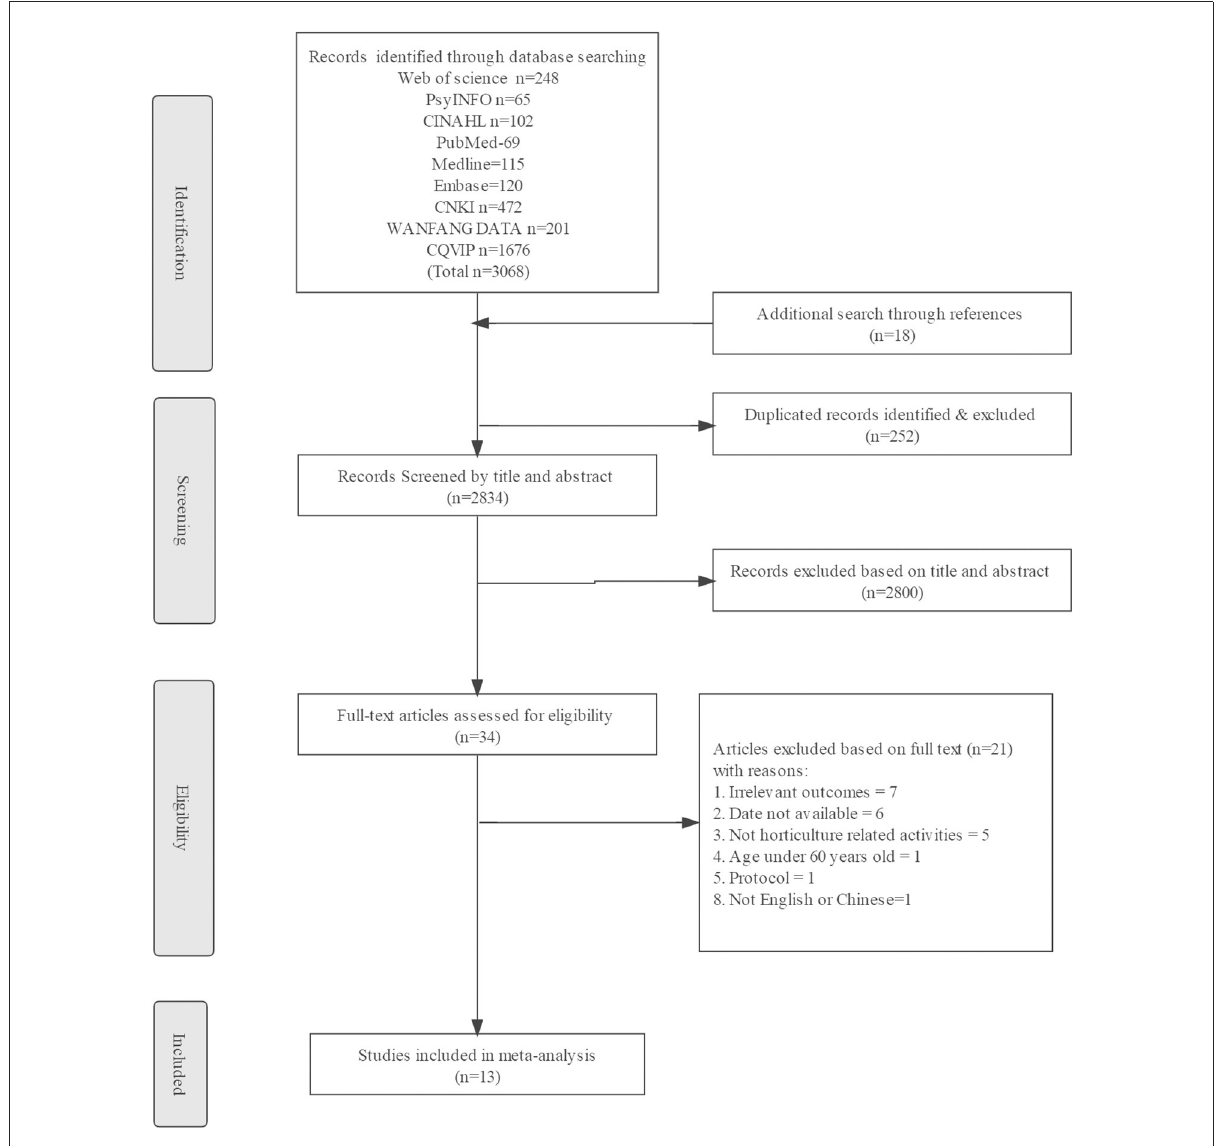
FIGURE1 Flow diagram of the literature search and selection